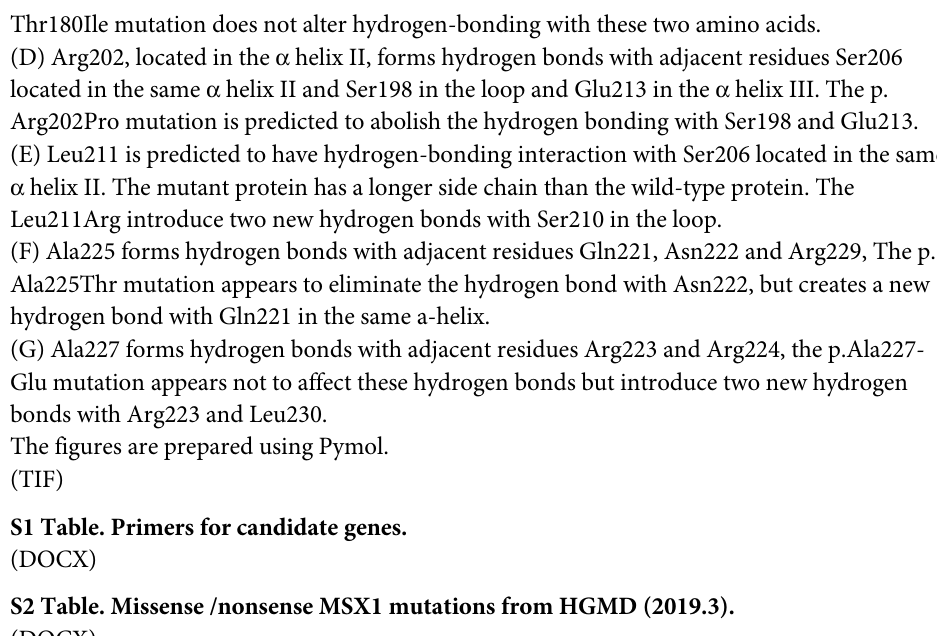
S1 Table. Primers for candidate genes. S2 Table. Missense /nonsense MSX1 mutations from HGMD (2019.3). S3 Table. The (average) number of patients and missing teeth in MSX1 mutations